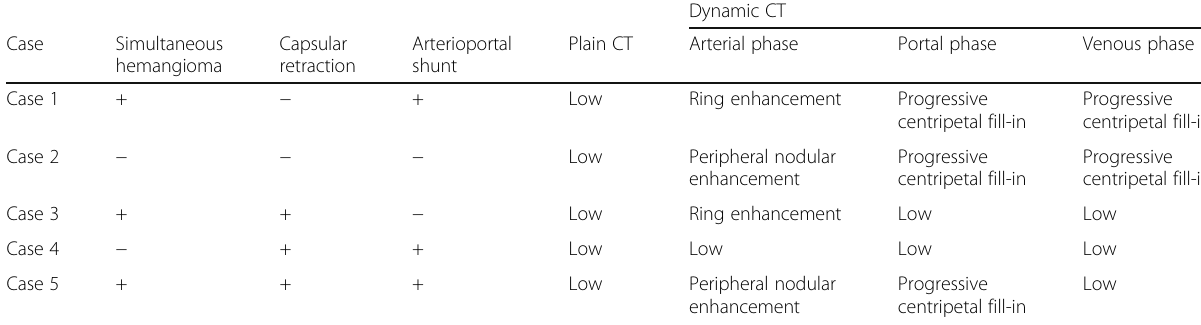
Table 2 Computed tomography (CT) features of five patients with hepatic sclerosed hemangioma